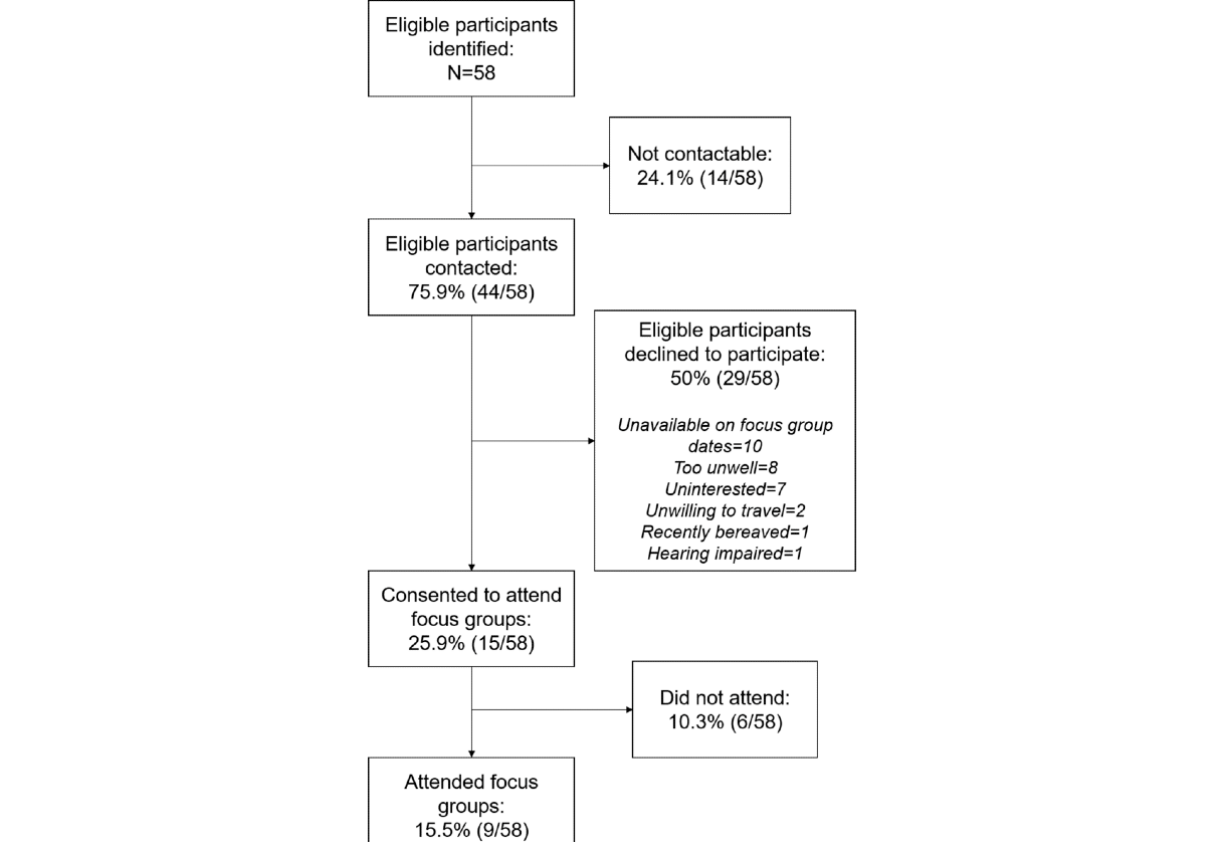
Figure 1. Participant flowchart. Percentages were calculated using the eligible participants identified (N=58) as the